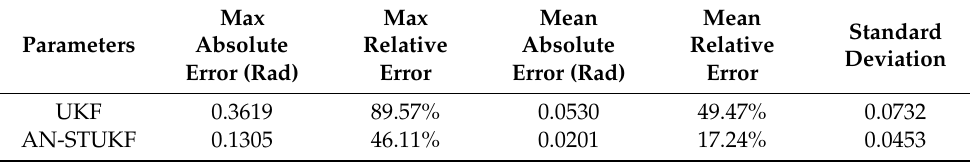
Table 2. Error analyses for small radius